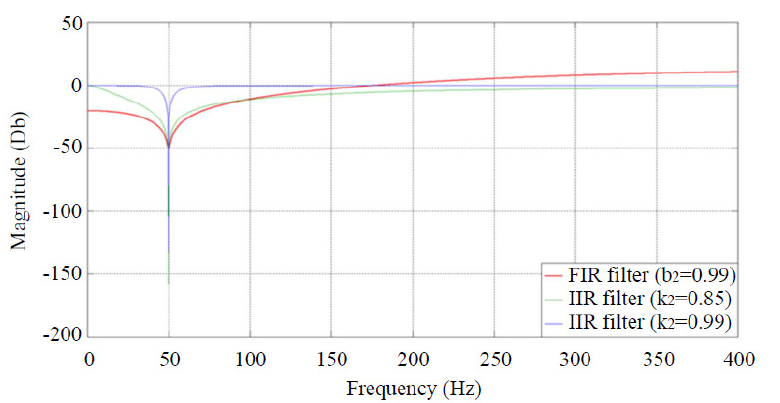
Figure 16. Amplitude characteristic of the notch filters.